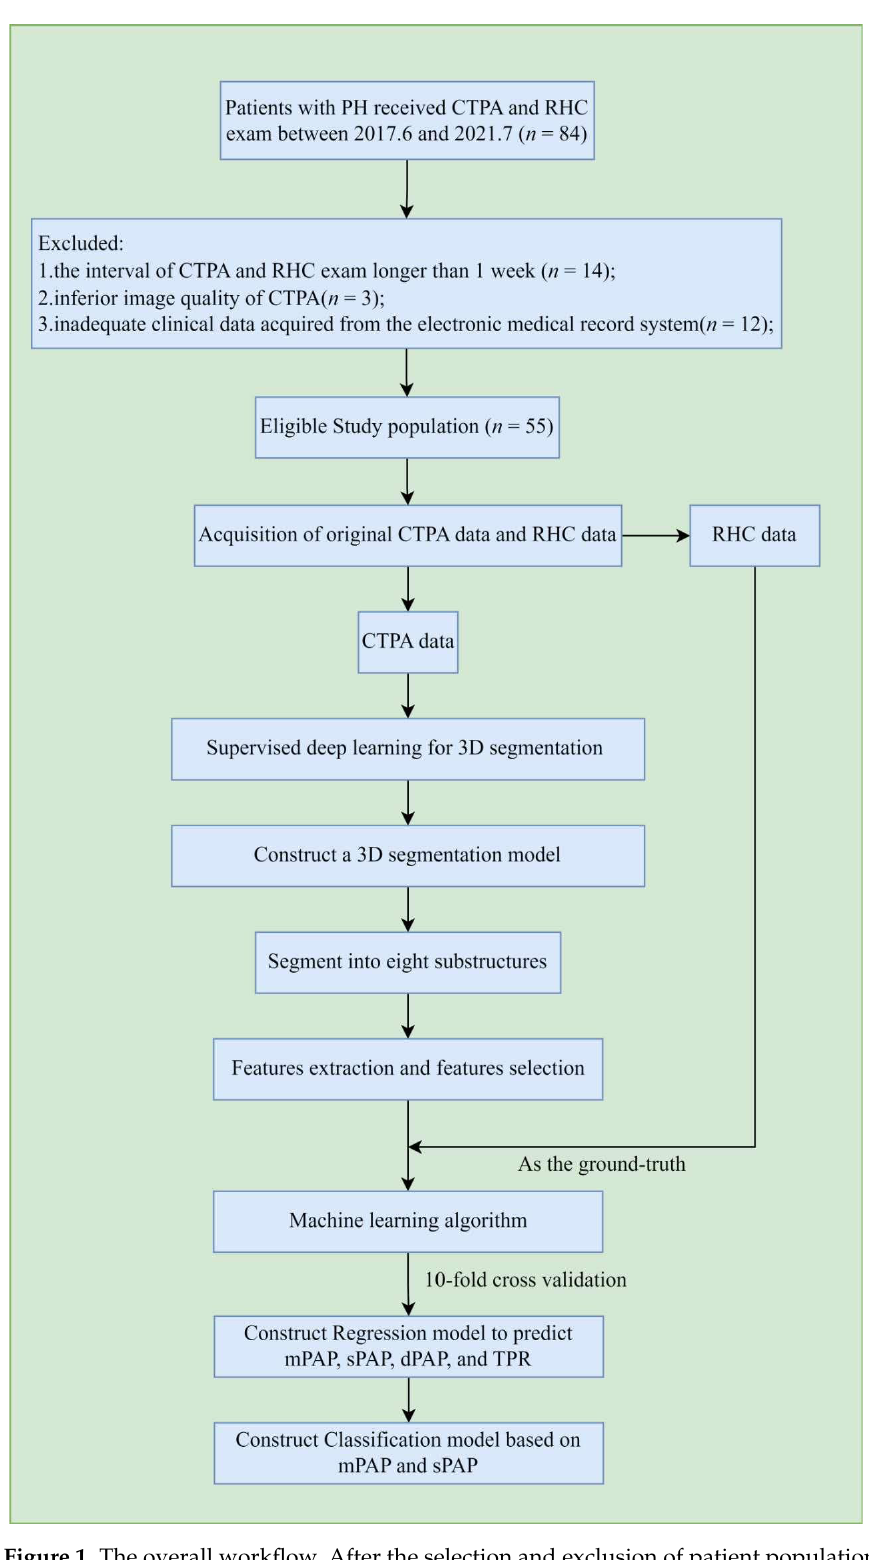
Figure 1. The overall workflow. After the selection and exclusion of patient population and CTPA images acquisition, eight substructures of heart and pulmonary arteries were automatically seg- mented as regions of interest (ROIs). Morphological features and their second-order features are extracted from these ROIs. Then, the essential features were selected through statistical methods and then reconstructed to reduce the redundancy of the features matrix. In the last step, meaningful features and corresponding results are set as an input through machine learning algorithms to obtain a regression model and a classification model.